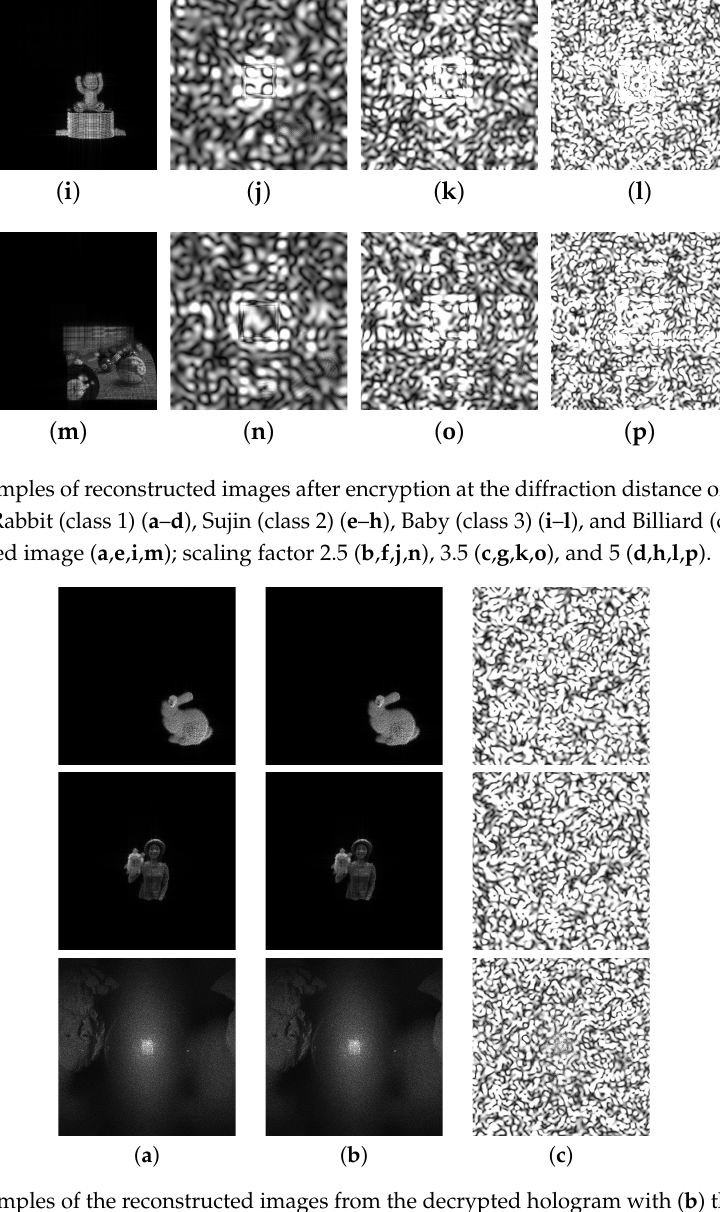
Figure 12. Examples of the reconstructed images from the decrypted hologram with ( b ) the correct key, ( c ) an incorrect key, whose original images are ( a